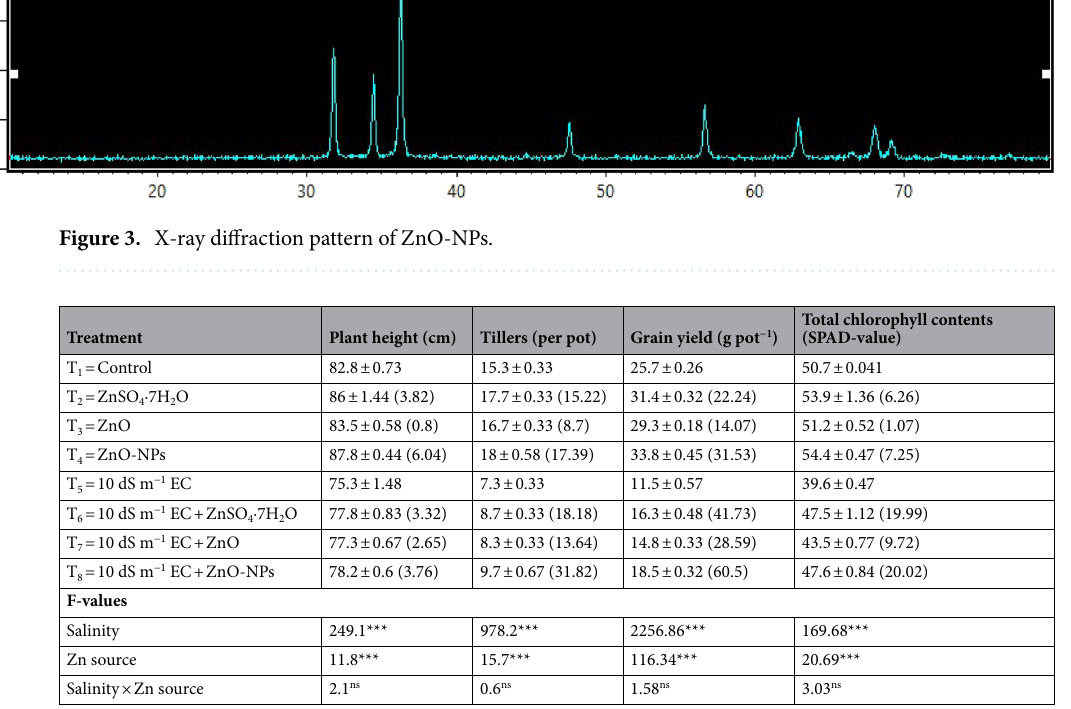
Table 3. Comparative effect of ZnO-NPs to other bulk Zn sources on growth and yield attributes of wheat. Values represent mean ± SE (n = 3). Values in parenthesis show percent increase or decrease from respective control. According to LSD test with multiple comparisons, F-values of the Two-way ANOVA are indicated as:ns not significant. *Significant at p ≤ 0.05. **Significant at p ≤ 0.01. ***Significant at p ≤ 0.00.